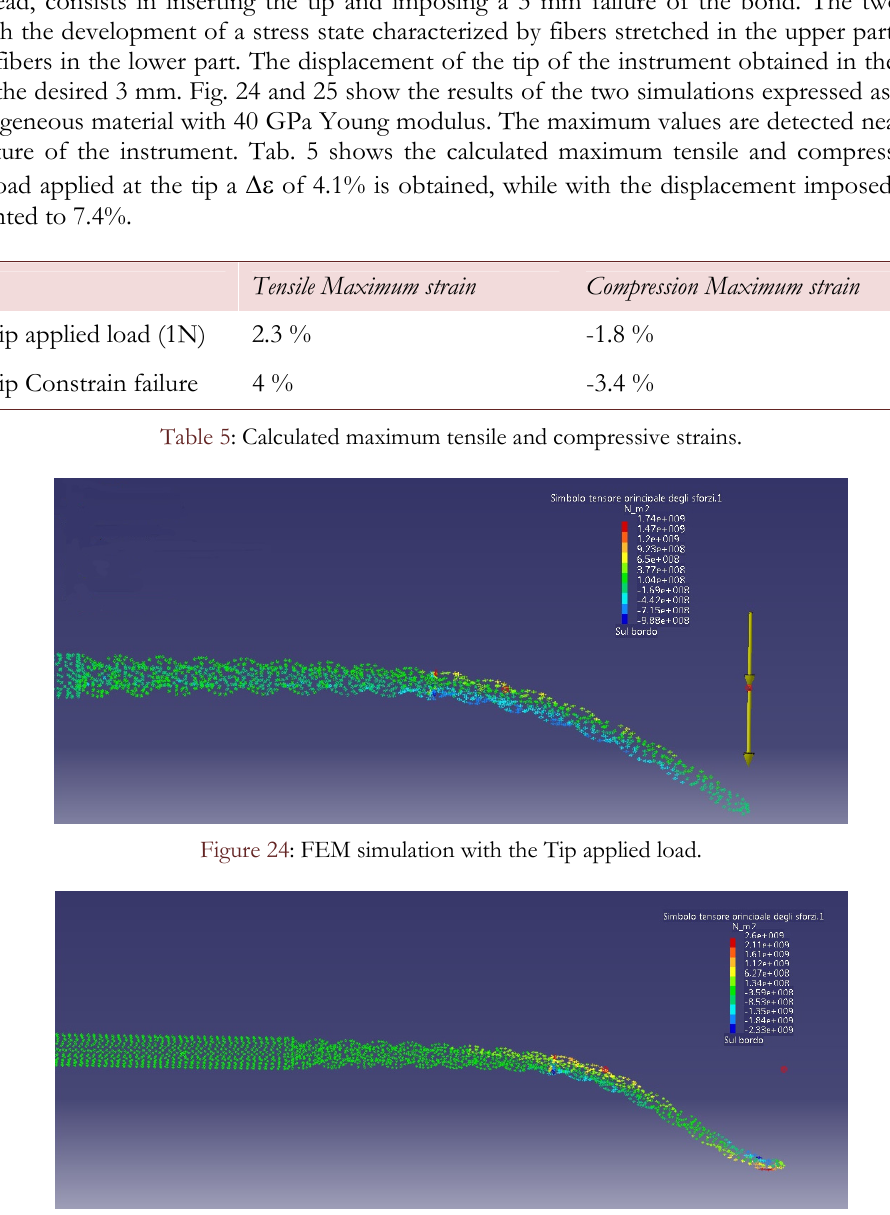
Figure 25: FEM simulation of the TIP constrain